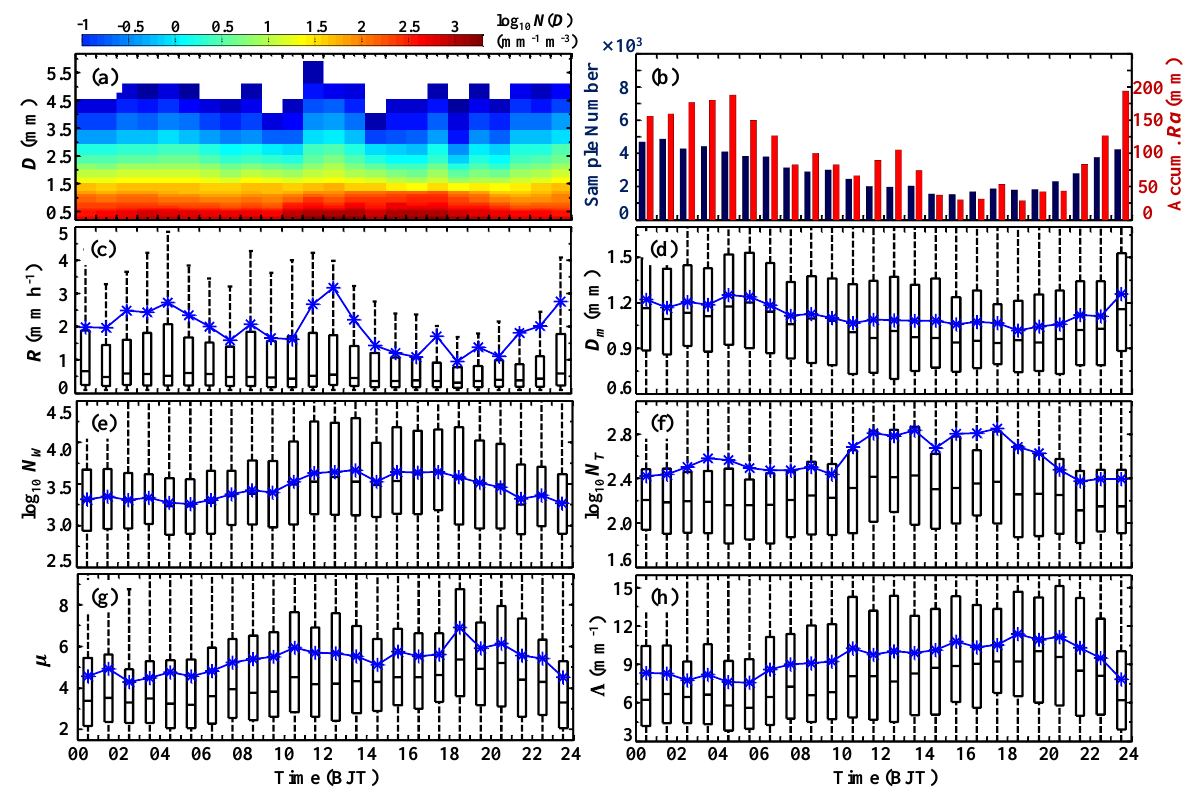
Figure 4. Hourly average RSDs ( a ), accumulated sample numbers and rain amount R a (mm) ( b ), and boxplots of rain rate R (mm h −1 ) ( c ), mass-weighted mean diameter D m (mm) ( d ), generalized intercept parameter 𝑁 𝑤 (m − 3 mm − 1 ) ( e ), total number concentration N T (m − 3 ) ( f ), Gamma shape parameter 𝜇 ( g ), and slope parameter 𝛬 (mm −1 ) ( h ). The blue asterisk denotes mean values. From the variations in the accumulated sample number, R a , and R (Figure 4b,c), we